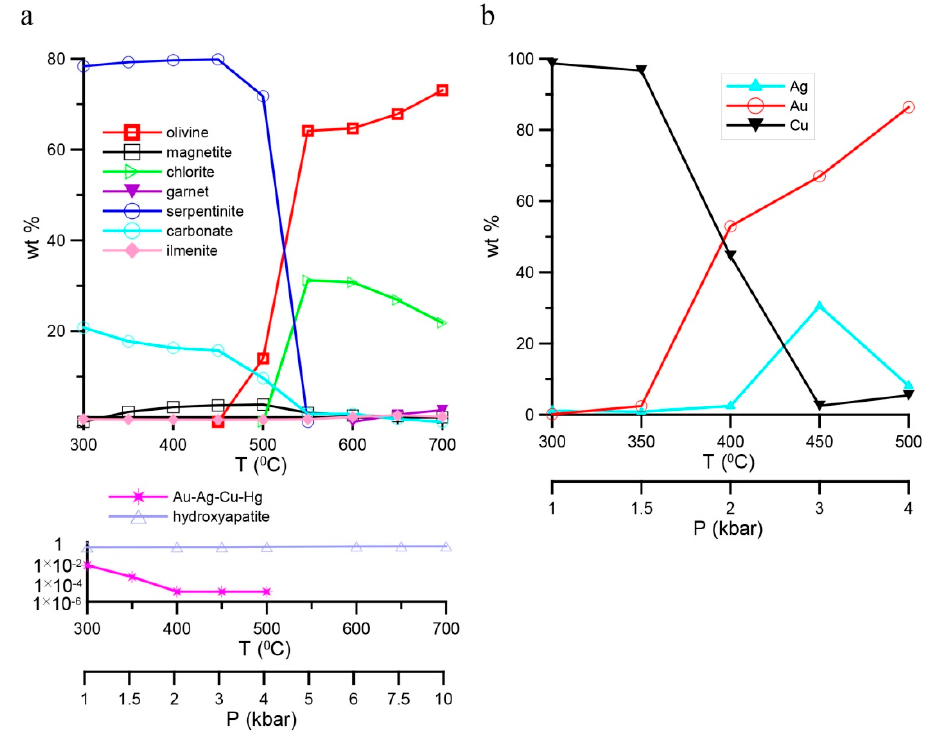
Figure 11. Mineral composition of ( a ) rocks and ( b ) Au-Ag-Cu solid solutions in changing pressure (P) and temperature (T) conditions.